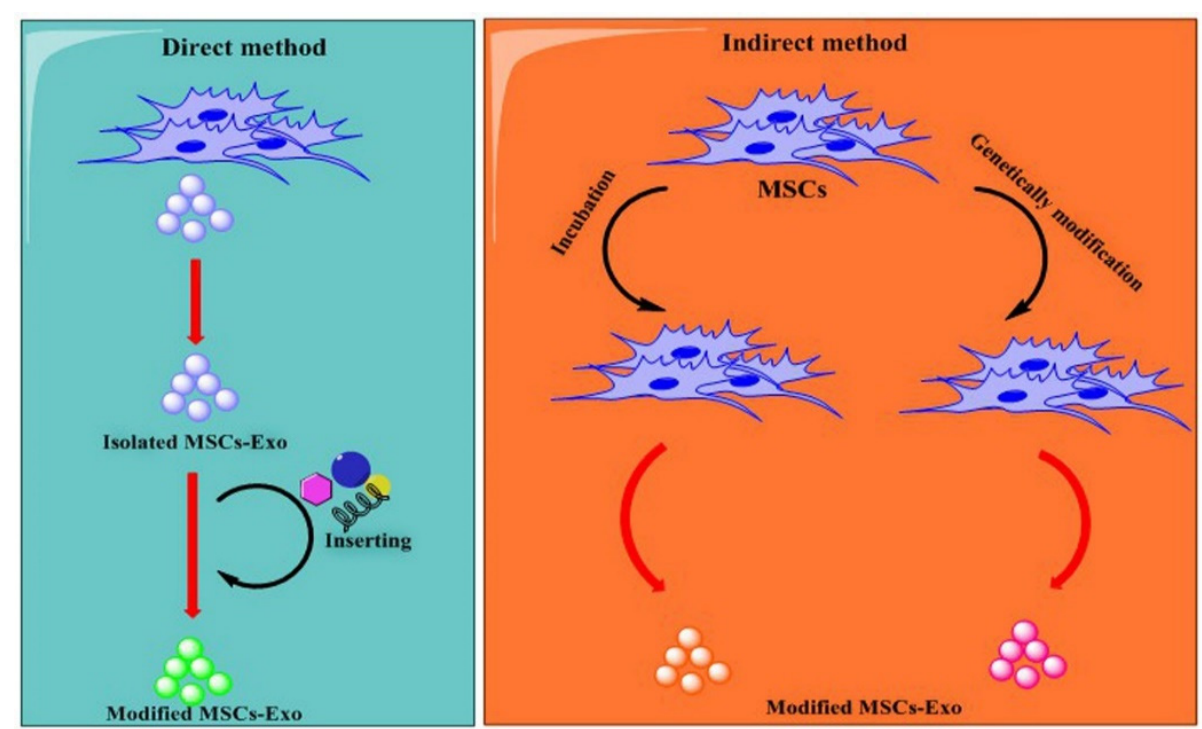
Figure 4. Exosomes from MSCs (MSCs-Exo) can be used as a drug delivery system. Commonly two methods are used to produce exosomes containing therapeutic agents known: the direct method and the indirect method. In direct method: MSCs-Exo are isolated and then loaded with therapeutic agents. In the indirect method: MSCs cells are modified to produce optional exosomes. Loading methods, including overexpression, transfection, electroporation, and incubation, are commonly used to load therapeutic agents.